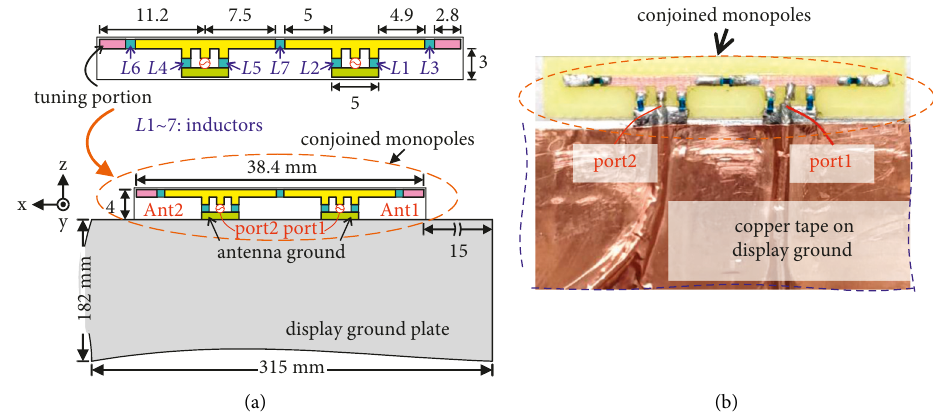
Figure 1: (a) Geometry of the conjoined MIMO antennas for Wi-Fi 6E notebooks. (b) Photo of a fabricated prototype.